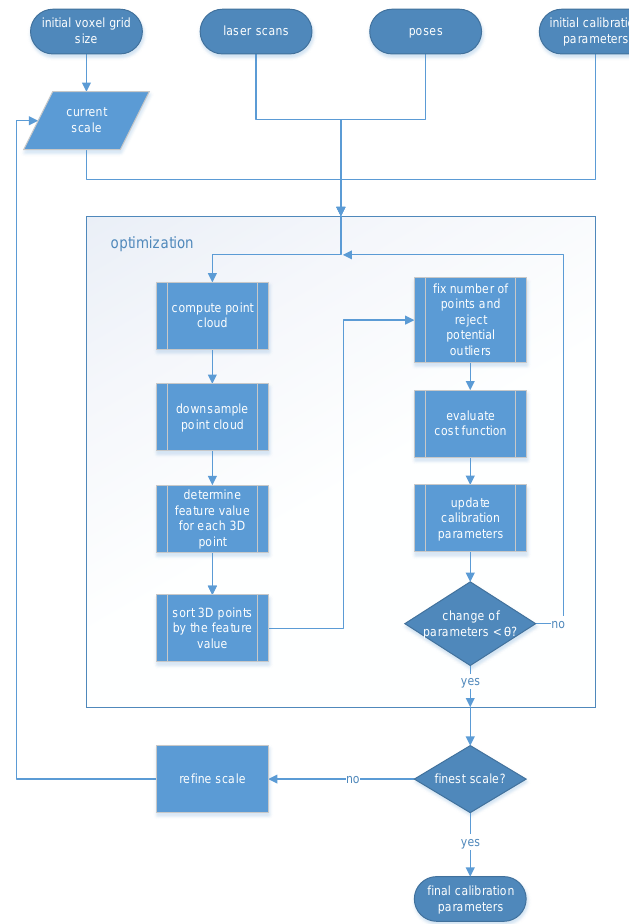
Figure 2. Workflow of the self-calibration. Besides the scan points and associated poses, initial calibration parameters and an initial voxel grid size are the inputs to a nonlinear least squares optimization. This optimization is performed recursively with multiple scales to be robust as well as accurate. It estimates the calibration parameters by minimizing an cost function which is based on a selected geometric